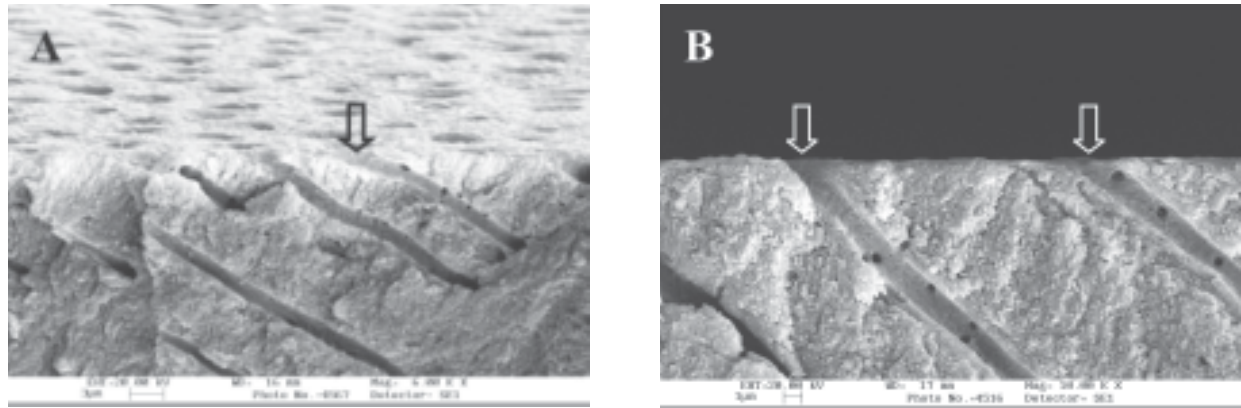
FIGURE 1- SEM micrograph of untreated dentin. No smear layer and smear plugs were observed. Open dentinal tubules are indicated by arrows. Lateral canals were seen in the tubule walls. (A: x 6,000; B: x